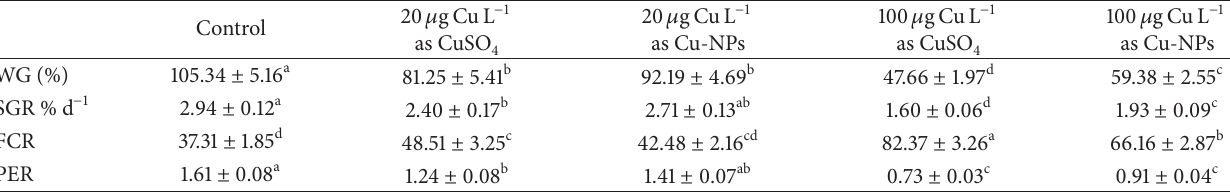
Table 1: Effect of Cu-NPs and CuSO on weight gain rate (WG, %), specific growth rate (SGR % d − 1 ), food conversion ratio (FCR), and 4 protein efficiency ratio (PER) of juvenile Epinephelus coioides after 25-day exposure.